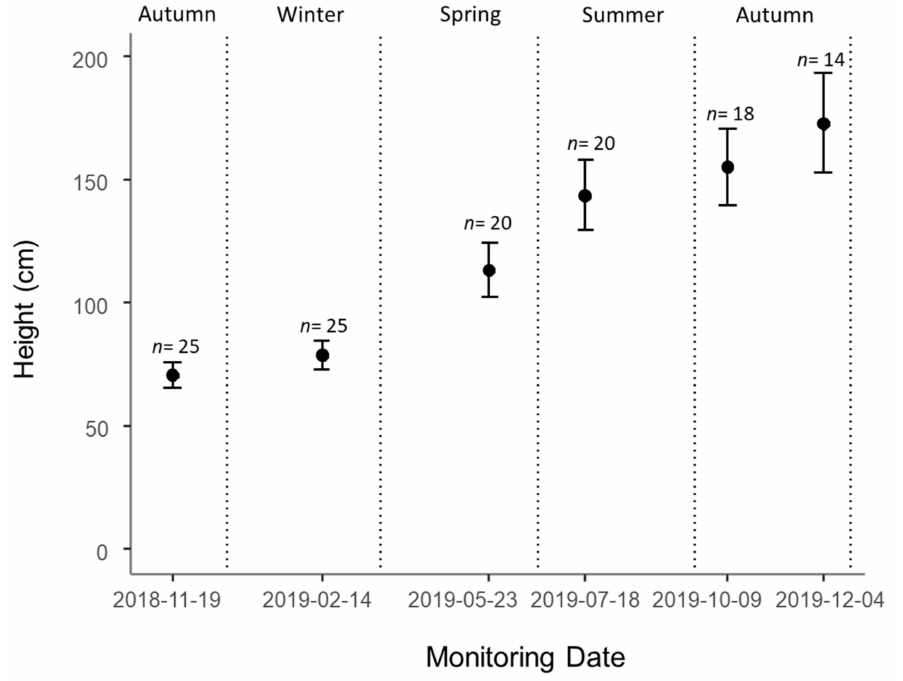
Figure 1. Average height of E. globulus wildlings (mean ± SE) registered in each survey, using the plants tagged in Control plots. Dashed lines represent the limits of each season.